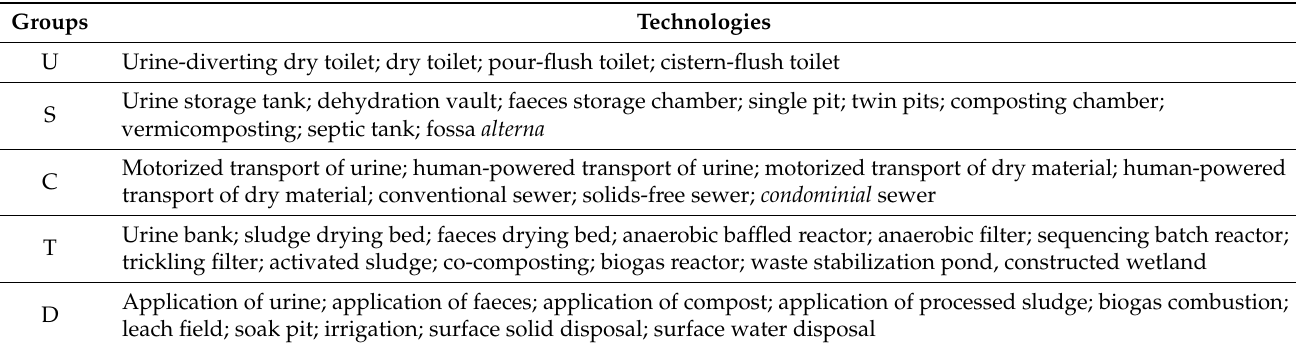
Table 2. List of potential technologies grouped by its functional groups 1 .